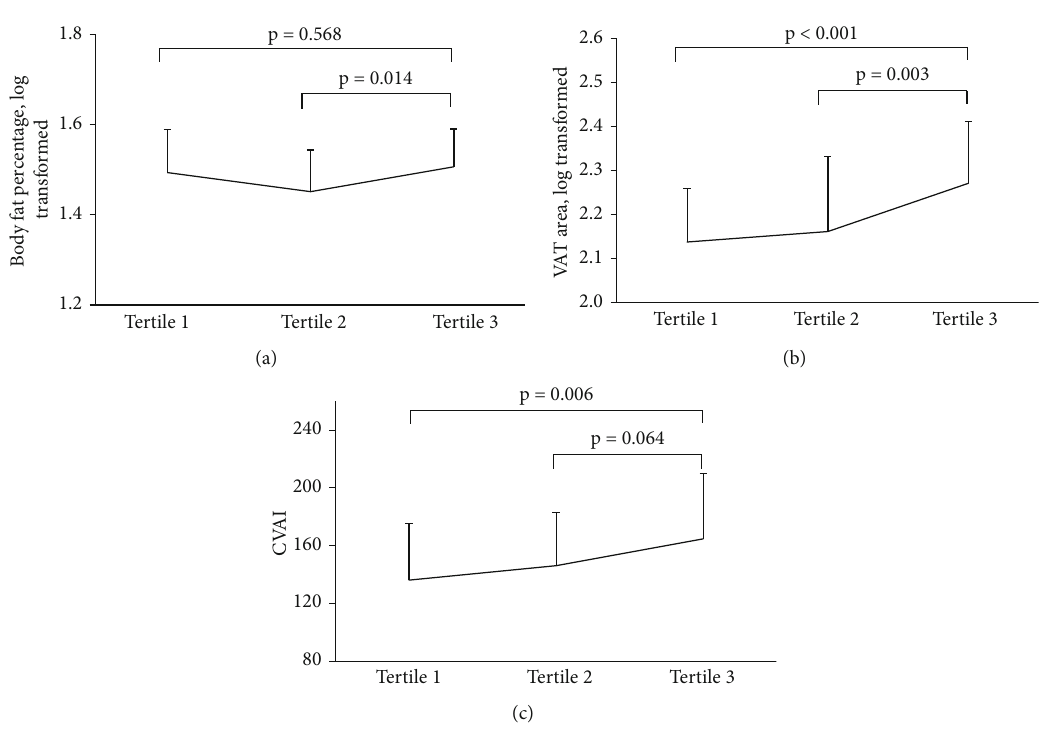
Figure 1: Distributions of body fat percentage, VAT area (log-transformed), and CVAI strati fi ed by AHI